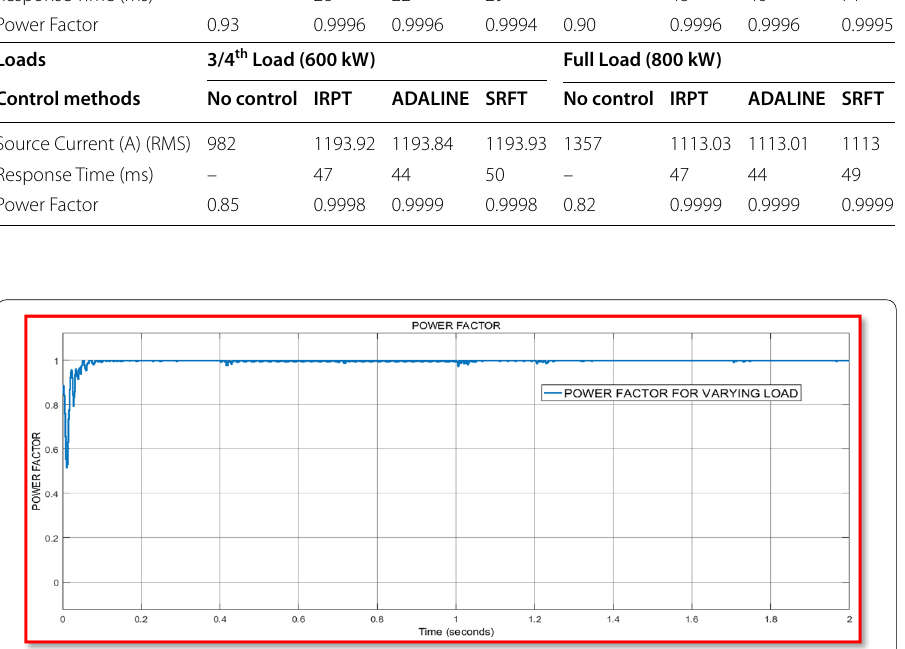
Fig. 19 Power factor of varying load with controller showing